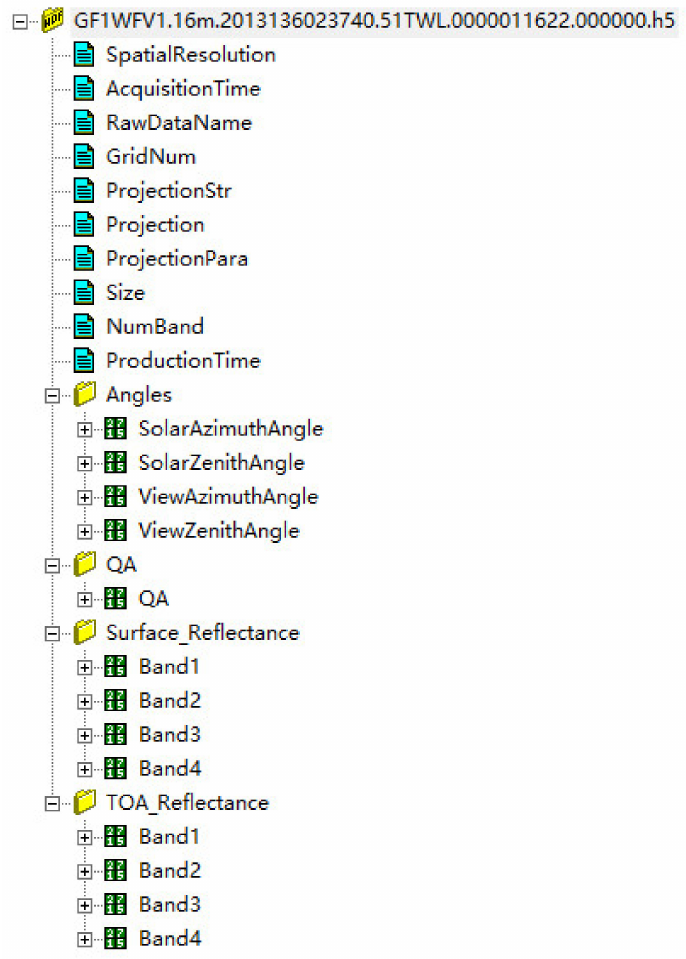
Figure 4. The structure of a typical GF1-WFV ARD HDF